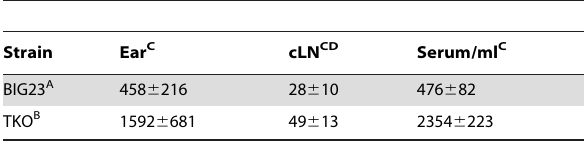
A Injection of 1 6 10 6 luminescent 7702 (BIG23) spores subcutaneously into left ear of 3 A/J mice. B Injection of 1 6 10 6 triple exotoxin knockout (TKO) spores with 100 ng LF plus 650 ng PA into left ear of 3 A/J mice. C LF detected by anatomic locations (pg/tissue 6 SE) 12 hours post inoculation. Average of three separate experiments with three mice. D Cervical lymph node.